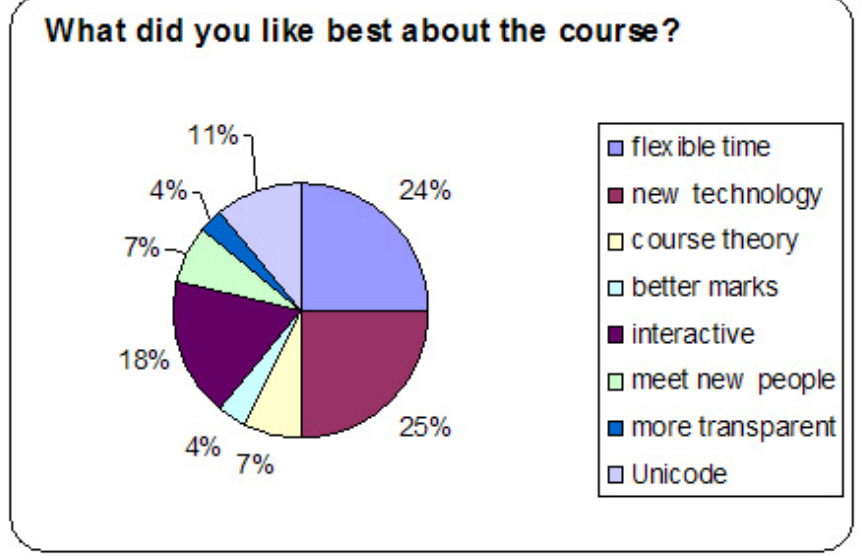
Figure 1. Characteristics of online courses most appreciated by